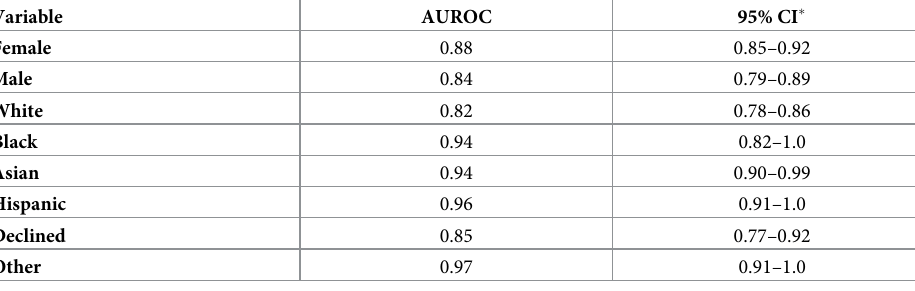
Table 6. Sensitivity analysis across gender/racial/ethnic